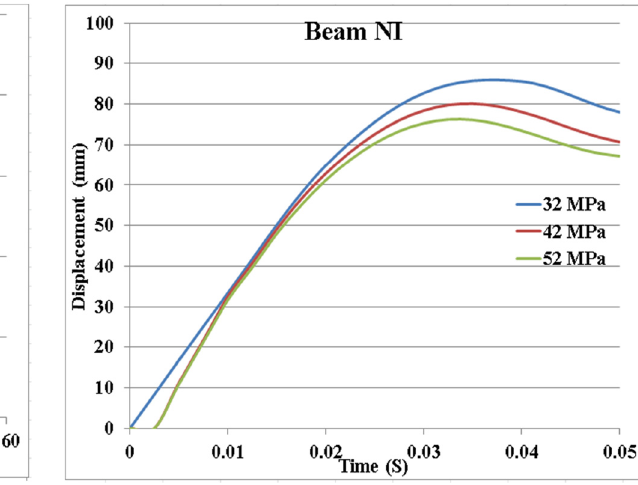
Figure 8: Maximum displacement of beams NI and CI versus the impact mass.